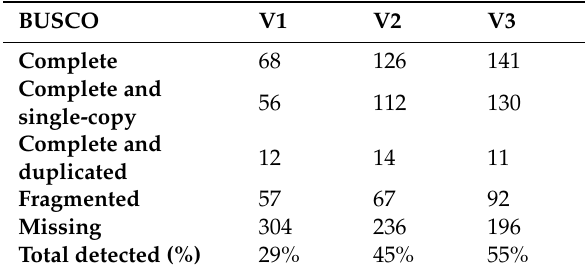
Table 3. BUSCO (429 orthologs protein) evaluation of gene set